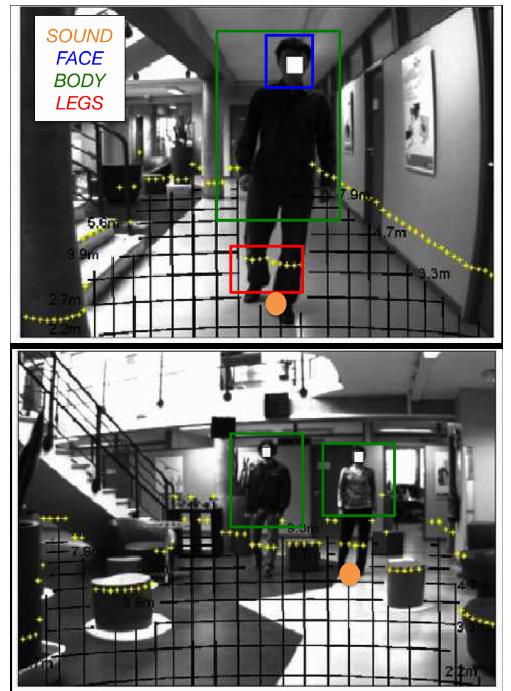
Figure 5. Graphical interface provided by SpirOps for the strategies definition.